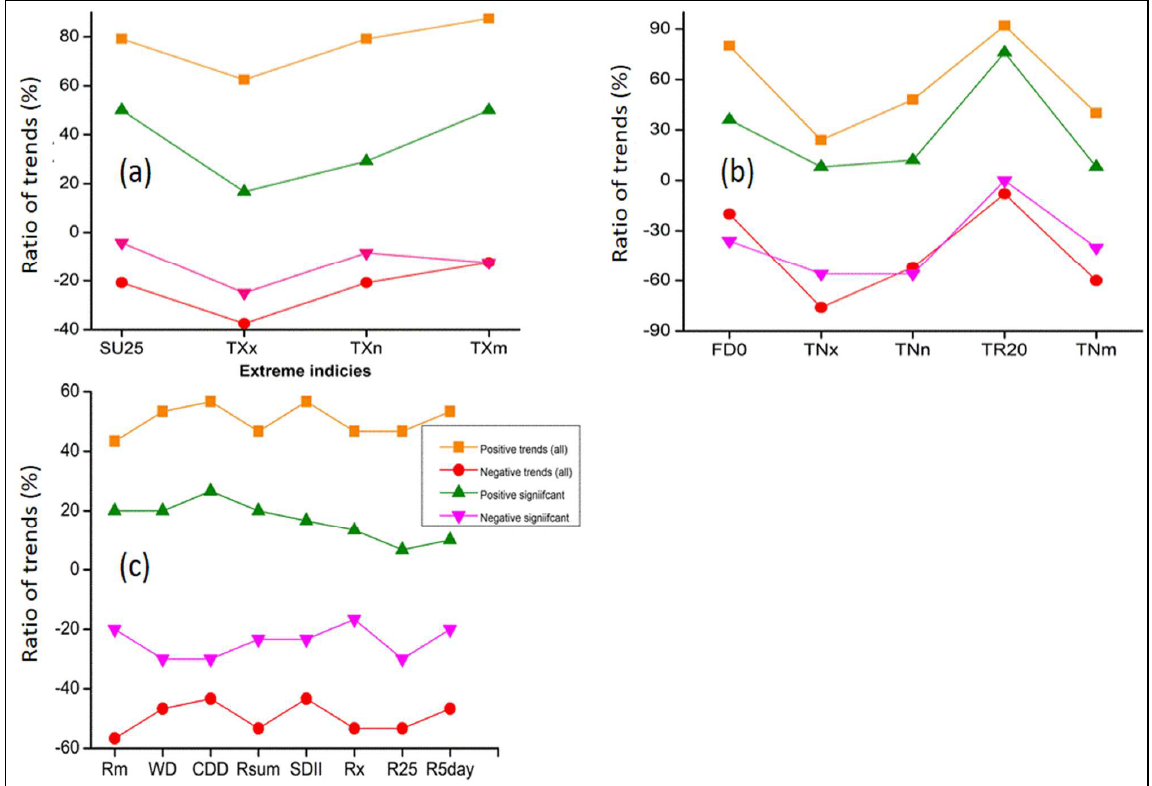
Figure 3. The number of stations in ( a ) Tmax indices, ( b ) Tmin indices, and ( c ) Pmean indices.